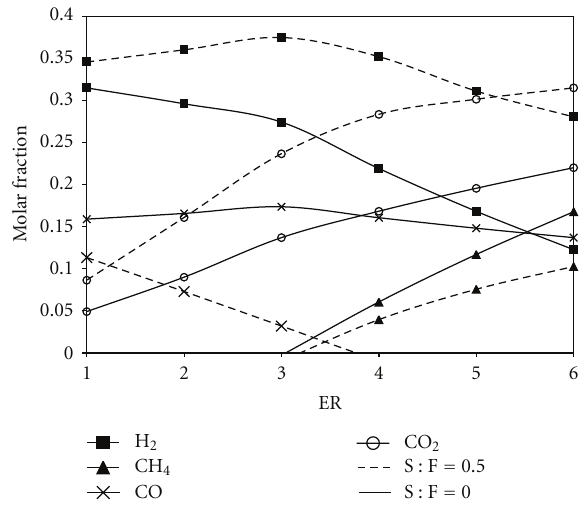
Table 4: Conditions used in thermogravimetric analysis. Parameter